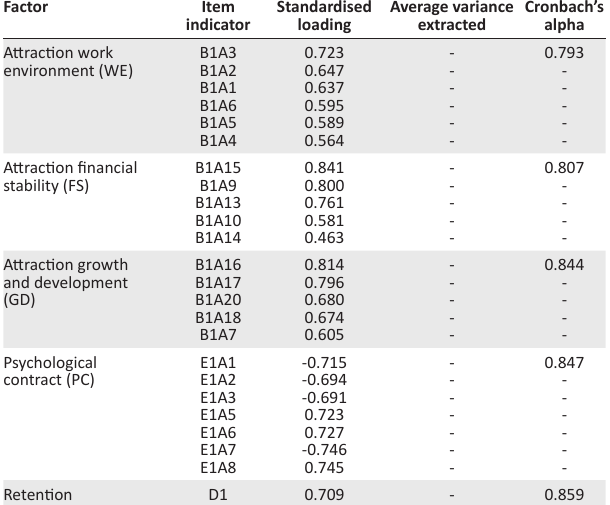
TABLE 2: Factor loadings of the variables. Factor Item